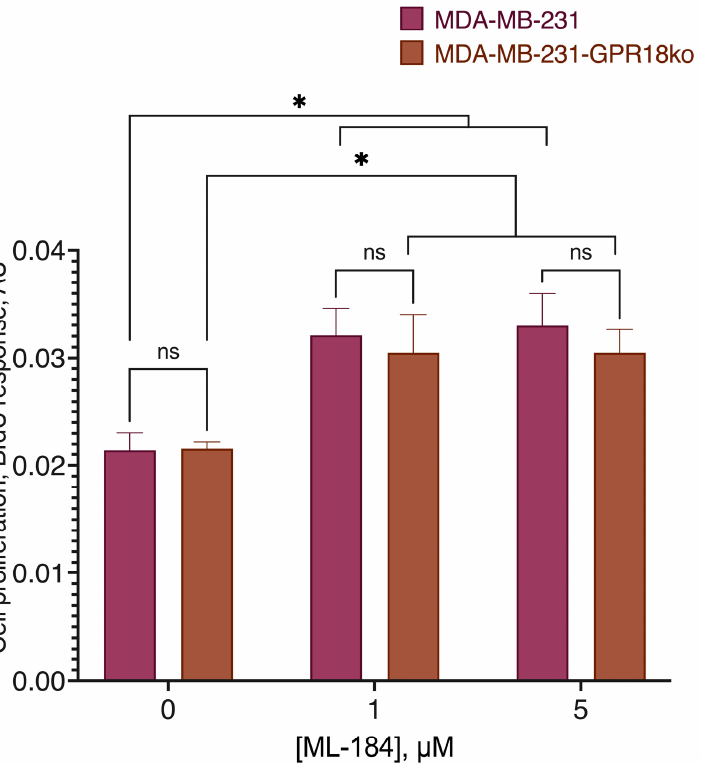
Figure 14. Comparison of the GPR55 agonist ML-184 activity on the original cell line and the line